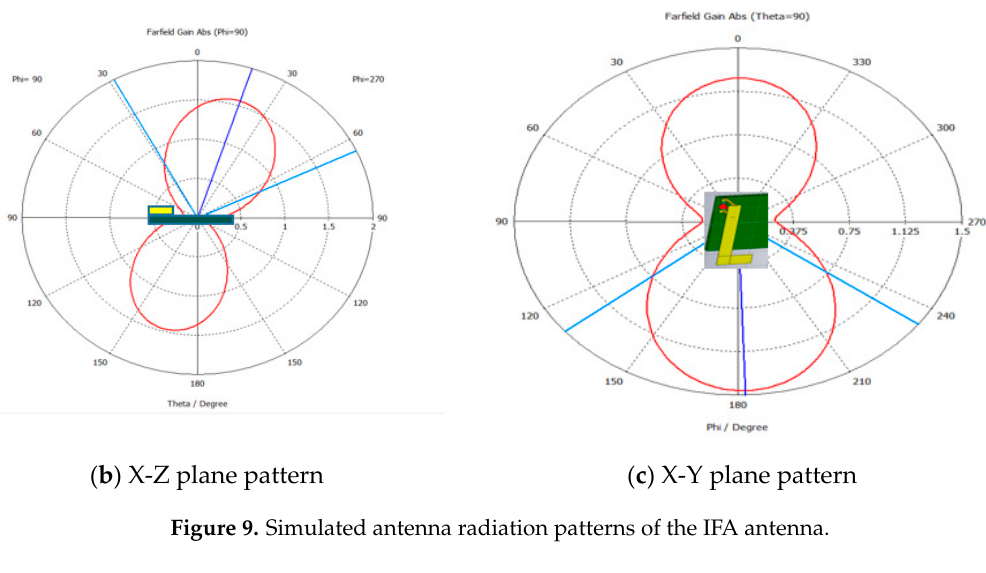
Figure 9. Simulated antenna radiation patterns of the IFA antenna.